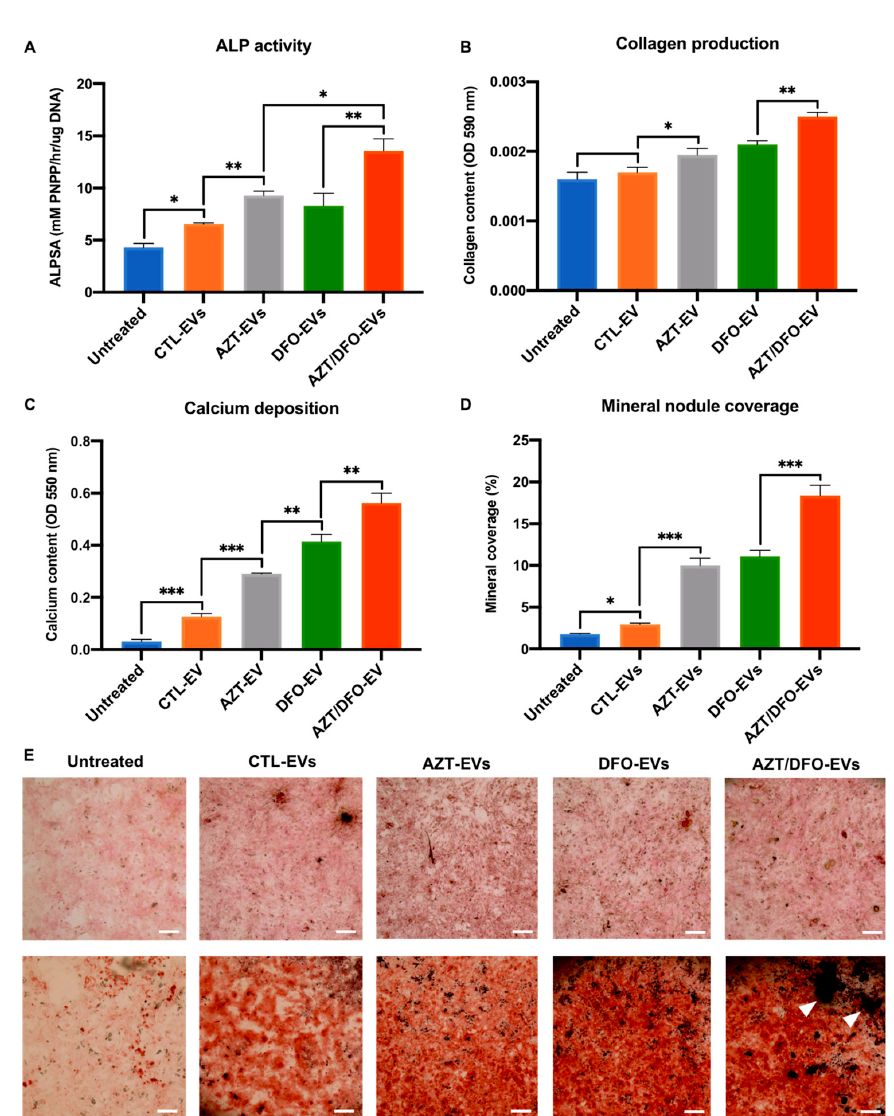
Figure 7. The AZT/DFO-EV treatment promoted osteogenic differentiation and extracellular matrix mineralisation in hBMSCs. The effects of AZT/DFO-EV treatment on hBMSC ( A ) ALP activity, ( B ) collagen production, ( C ) calcium deposition and ( D ) mineral nodule coverage. ( E ) Picrosirius red collagen staining and Alizarin red calcium staining of EV-treated MSCs. Black staining indicates mineral nodule formation (white arrows). Scale bar = 200 µ m. Data are expressed as mean ± SD ( n = 3). * p ≤ 0.05, ** p ≤ 0.01 and *** p ≤